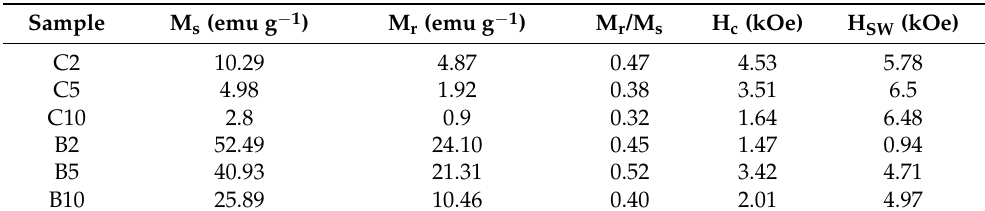
Table 3. Magnetic properties for the Mn 52 Al 45 . 7 C 2 . 3 samples after milling in cylindrical and barrel containers for 2, 5, and 10 h.